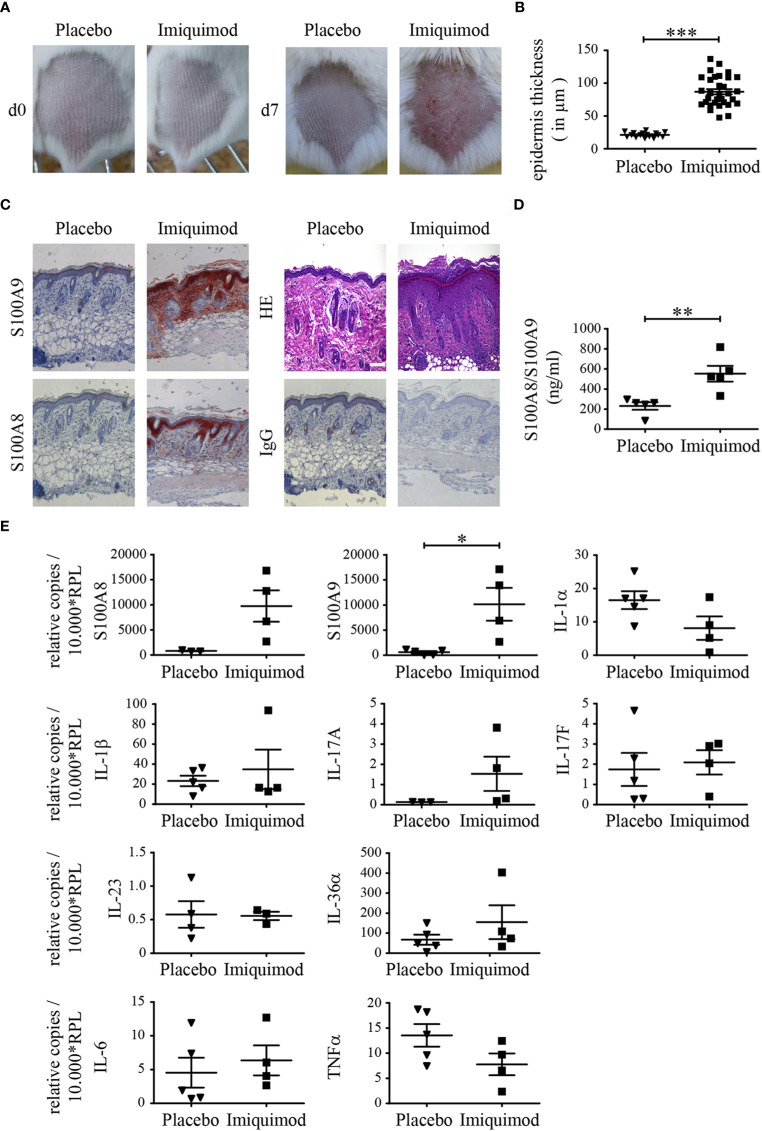
S100A8 and S100A9 are up-regulated in psoriasis like skin inflammation. Naïve BALB/c mice were treated with imiquimod (IMQ) or placebo cream for 7 consecutive days. (A) Typical skin appearance of IMQ- or placebo cream treated BALB/c mice (n = 5 per group). (B) Quantitative measurements of epidermal thickness are shown as means ± SEM. Student’s t-test ***p < 0.001. (C) Representative paraffin skin sections stained with anti-S100A8, anti-S100A9, IgG control and HE. One representative image for each condition is shown (original magnification 10 x, scale bar = 100 µm). (D) Serum concentrations of S100A8/S100A9 in mice was analyzed via ELISA after 7 days of IMQ treatment (▪) and controls (▼) (Student’s t-test **p < 0.01). (E) Differential expression pattern of S100A8, S100A9 and various cytokines on transcriptional level in IMQ (▪)- and placebo (▼)- treated skin sections. Transcripts were measured by quantitative real-time PCR and normalized to RPL housekeeping gene. Values are expressed as mean ± SEM (n ≥ 3 mice per group; Student’s t-test *p < 0.05).